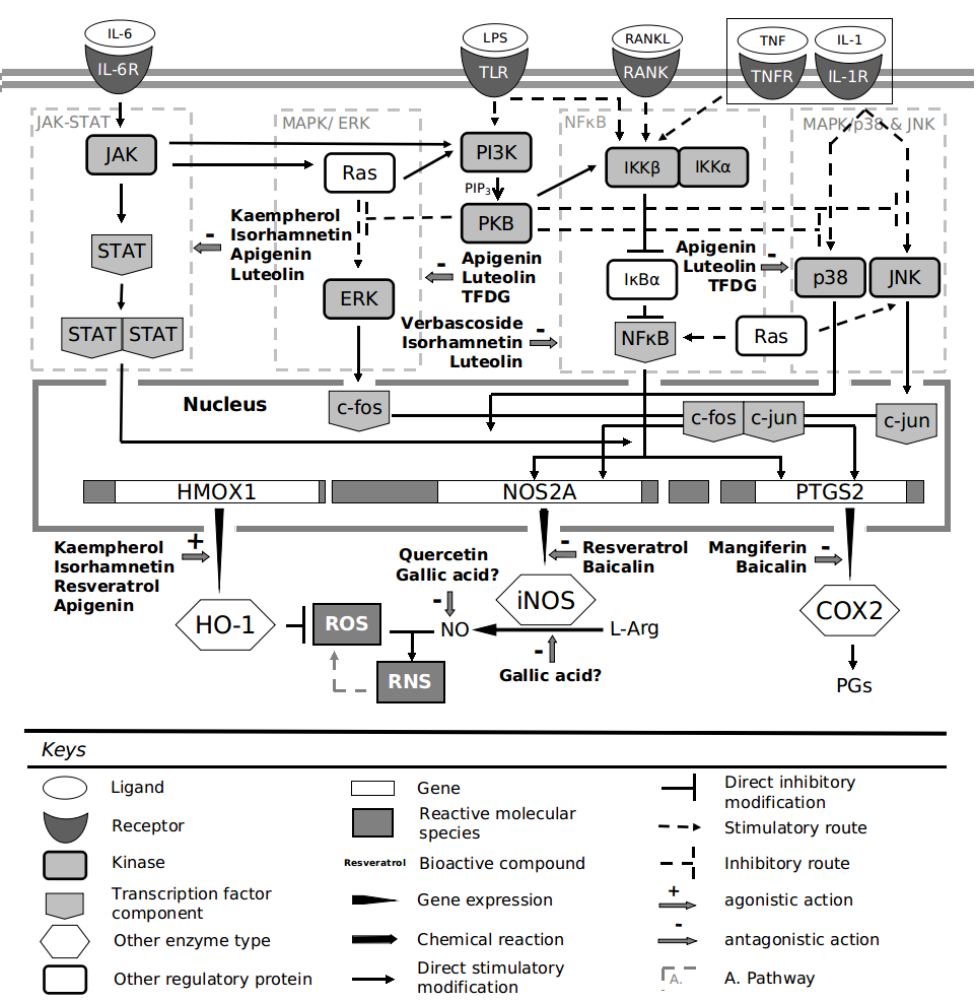
Figure 1. Main phenolic compound effects on cell signaling pathways and enzyme implicated on oxidative/nitrosative stress and inflammation. Acronyms